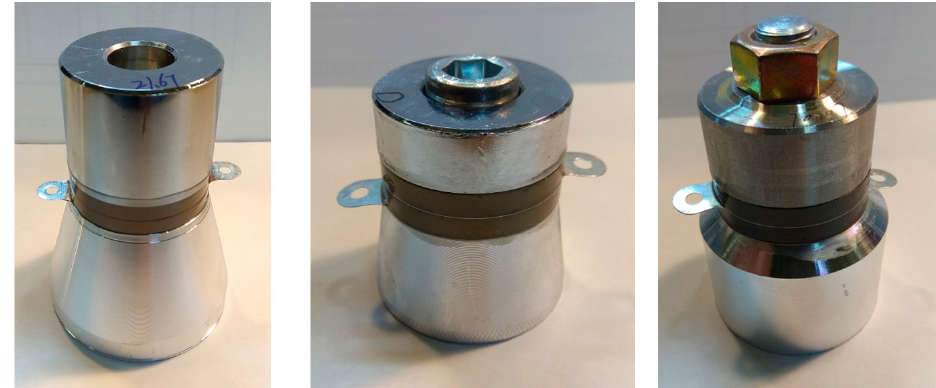
Figure 3. Applied piezoceramic ultrasound transducers (22 kHz, 40 kHz and 70 kHz).